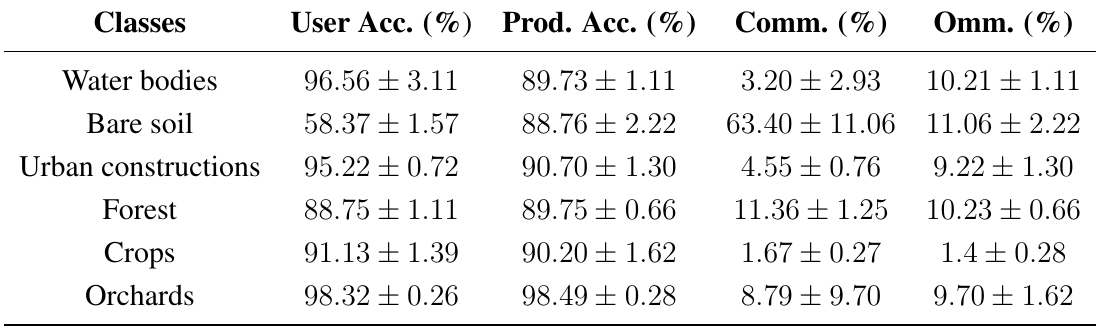
Table 3. Accuracy assessment of the classification at superpixel level.